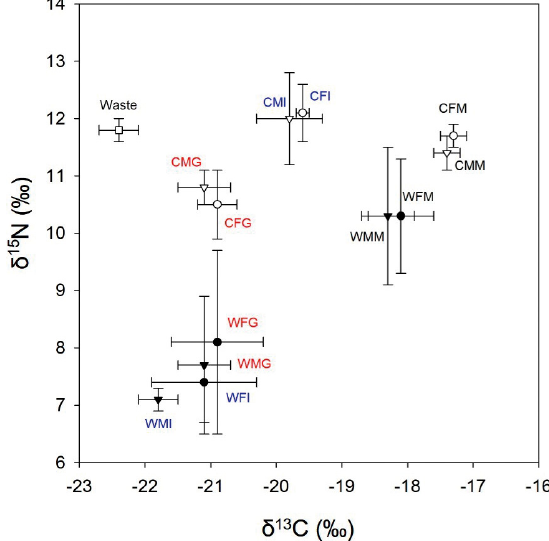
Fig. 3. Biplot of δ 13 C and δ 15 N in the muscle bands, intestine and gonad of wild and captive (45 mo under IMTA condi- tions) Cucumaria frondosa (males and females) and in the waste from salmon tanks (food for captive individuals). All data are shown as means ± SD (n = 4). WMM (WFM): wild male (female) muscle bands; WMI (WFI): wild male (female) intestine; WMG (WFG): wild male (female) gonad; CMM (CFM): captive male (female) muscle bands; CMI (CFI): cap- tive male (female) intestine; CMG (CFG): captive male (fe- male) gonad. To clearly identify different tissues, the abbre- viations for muscle bands, intestine and gonad are shown in black, blue and red, respectively. The triangles and circles represent male and female individuals, respectively, and the closed and open symbols represent wild and captive individ- uals, respectively. The open square corresponds to salmon culture waste